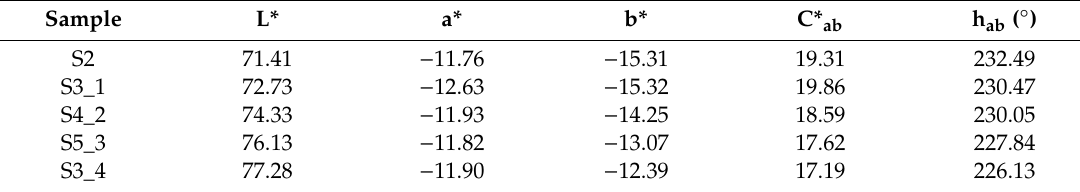
Table 5. The CIELAB color values, chroma (C* ab ) and hue (h ab ) of coated samples after exposure for 1 min to UVA